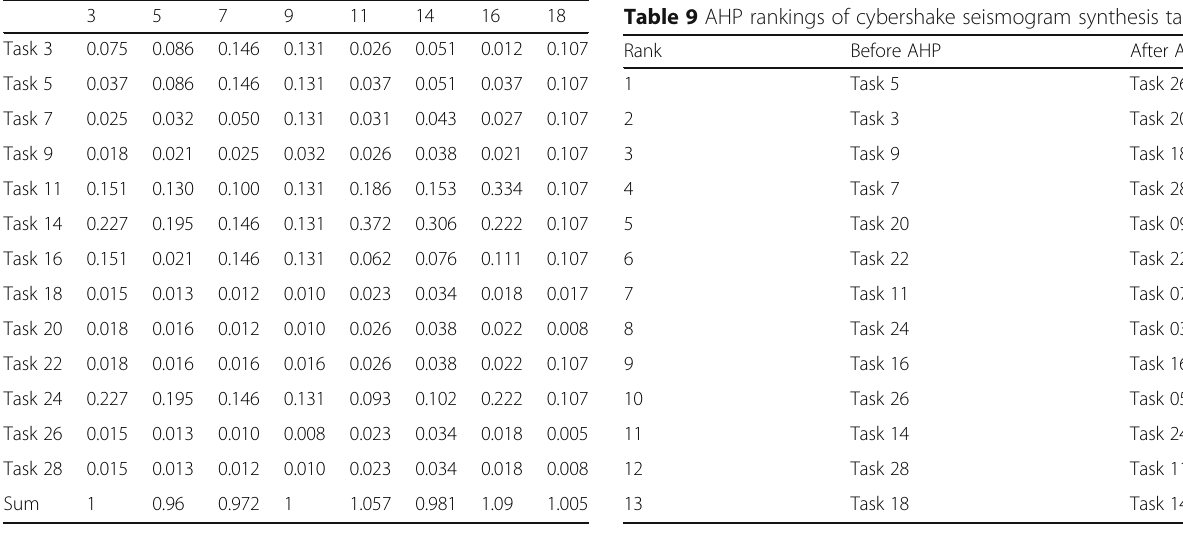
Table 7 Compute weighted sum-I